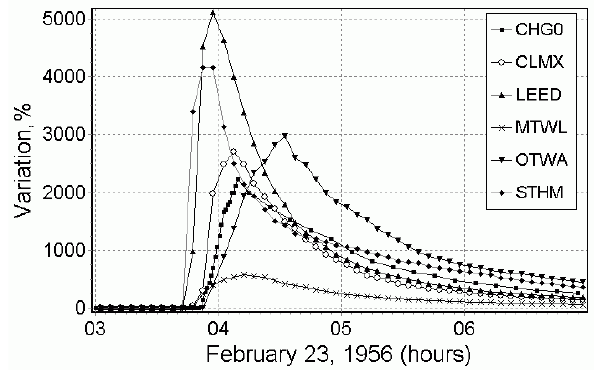
Fig. 4. Profiles of the cosmic ray enhancement recorded at different